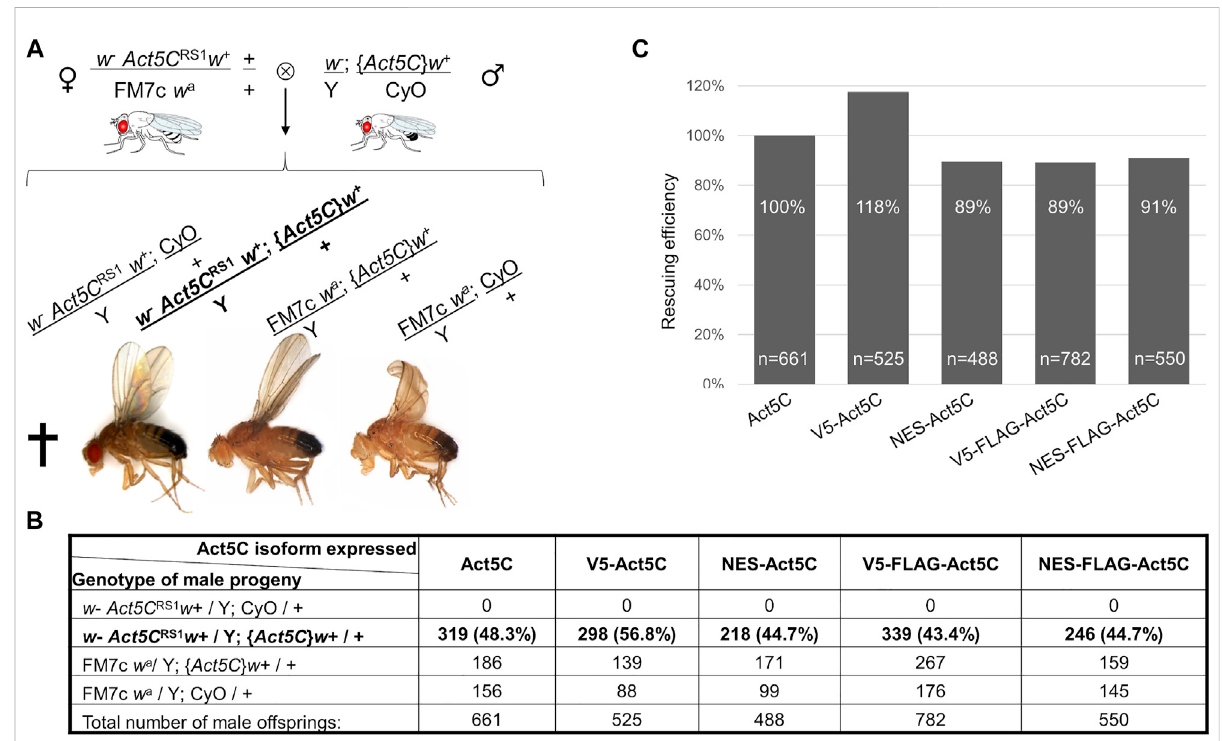
FIGURE 2 NES tagging of actin has no effect on viability. (A) General scheme of the rescue experiments, and the genotype categories and phenotypes of male F1 progeny. Act5C RS1 symbolizesthenull allele of the Actin5C gene, { Act5C }symbolizesActin5C expressing transgene, cross indicates lethality. Thegenotypeofrescuedmales isinbold. (B) Thenumber ofmaleF1progeny ofthedifferentgenotypes in fi verescue experiments.The genotype of rescued males is in bold. (C) Bar chart presentation of the data in (B) . The rescue effect (percentage ratio of the rescued category) of wild